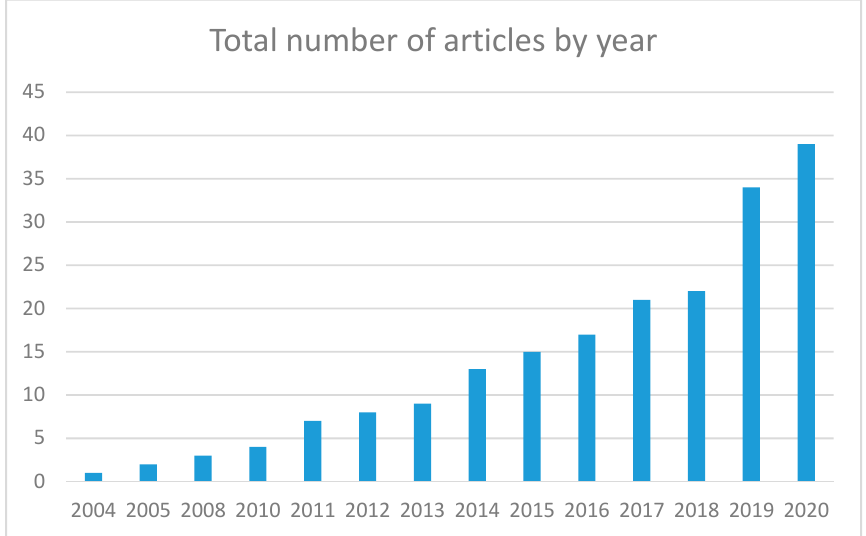
Figure 1. Publications per year during the last two decades on the use of 1,2,3-triazoles in corrosion science, using Scopus as a scientific search platform. The following keywords are used for the search: 1,2,3-triazoles, click chemistry, corrosion inhibition, acid media.